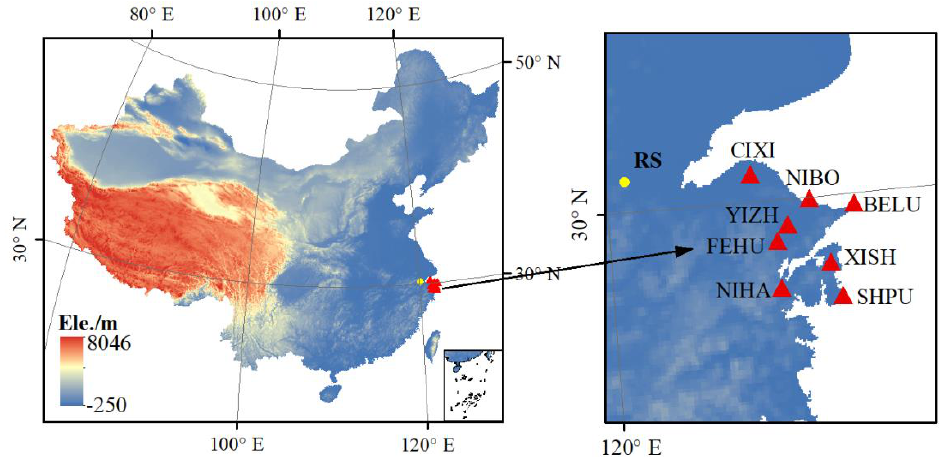
Figure 1. Geographical distribution of ground-based GNSS stations and radiosonde station.